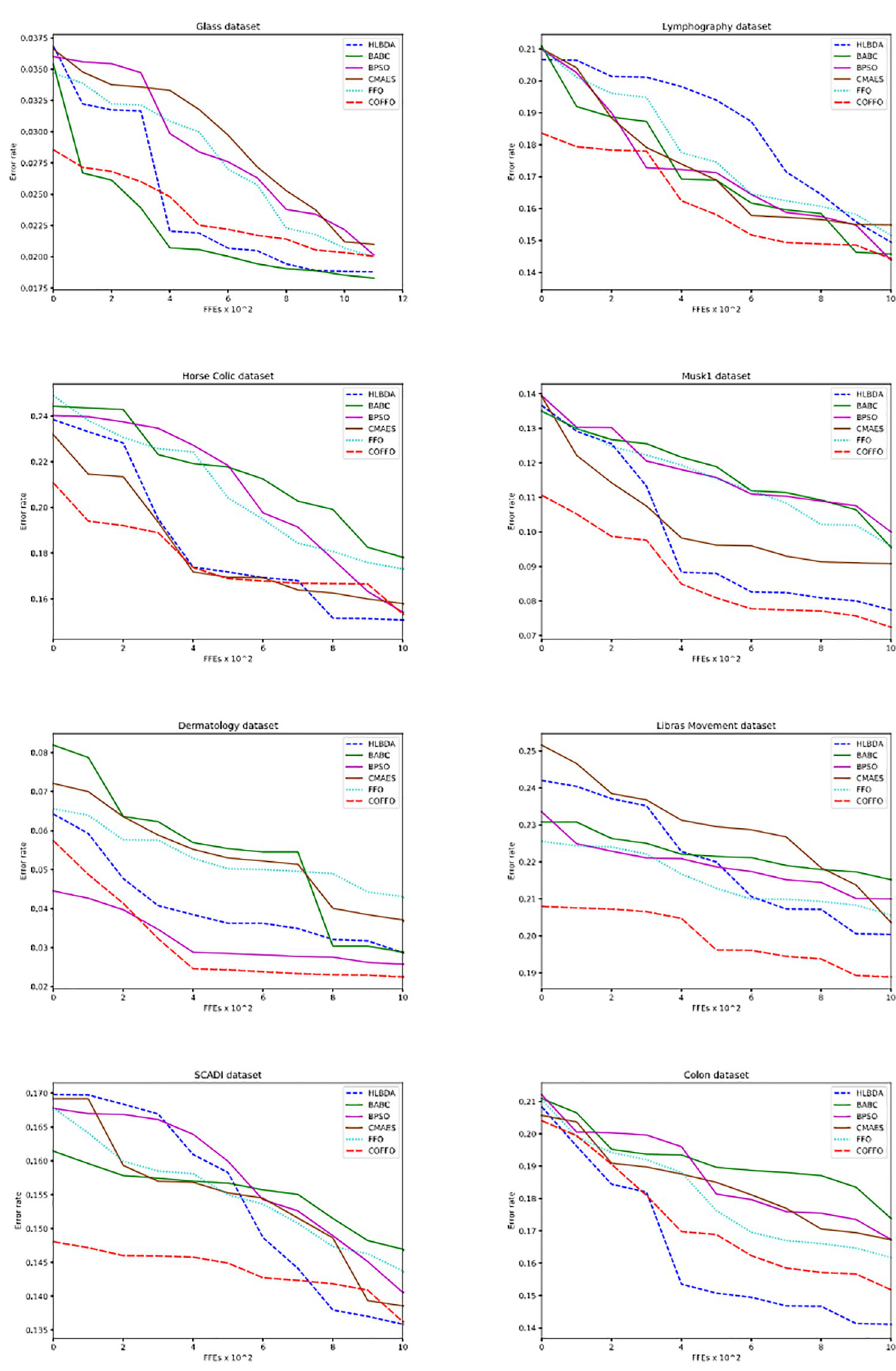
Fig 4. Error rate convergence